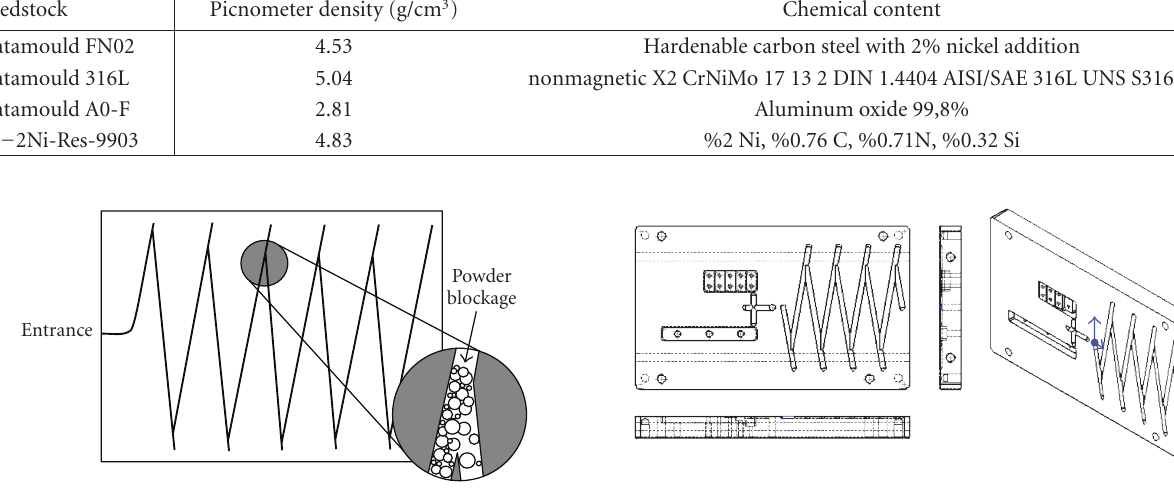
Figure 4: Zigzag test mould used for PIM feed stock experiments [2, 13].